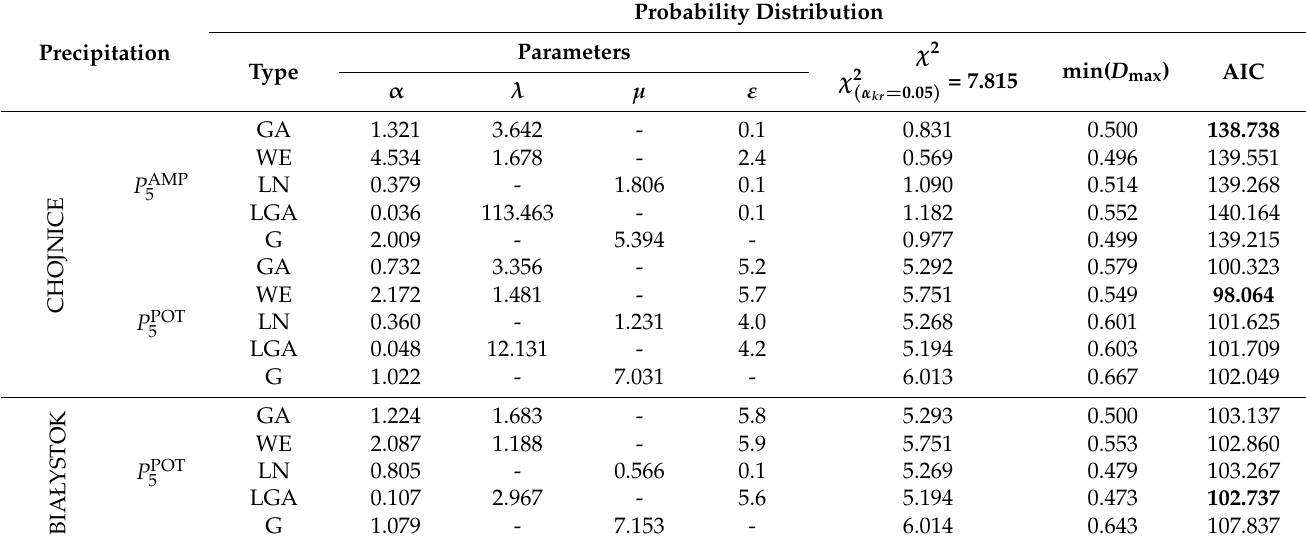
Table 7. Sample results of the procedure to select probability distributions for maximum precipitation values P AMP τ and P POT τ